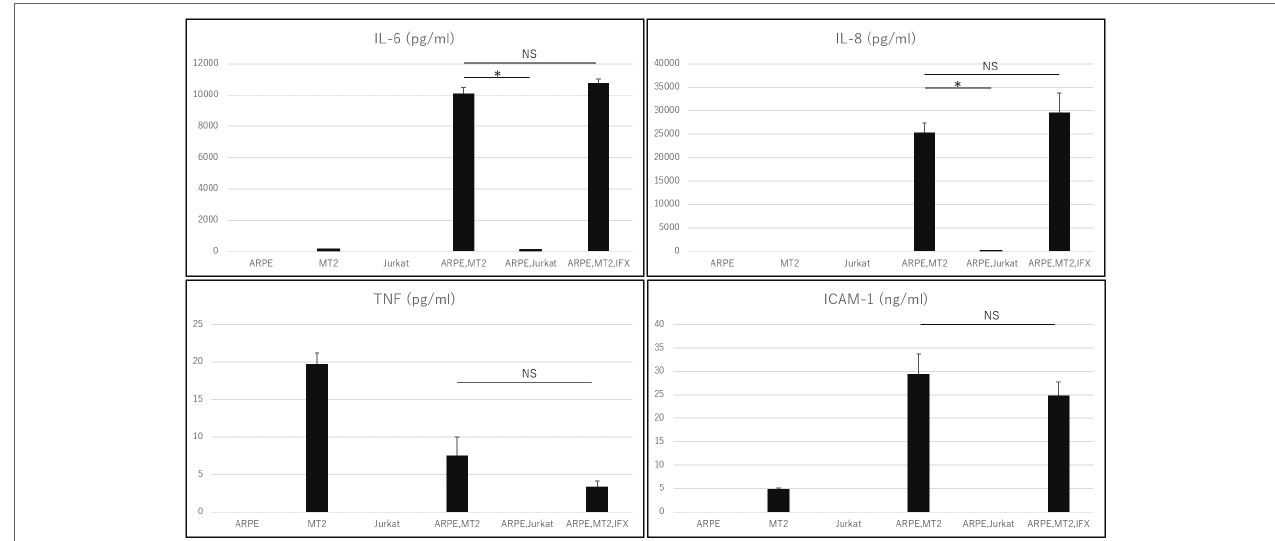
FIGURE 1 | Inflammatory cytokines and ICAM-1 secreted by ARPE, MT2, Jurkat, and ARPE-19 co-cultured with MT2 or Jurkat, and ARPE-19 co-cultured with MT2 with addition of IFX at 48 h. Although TNF tends to be inhibited by IFX, no significant difference is detected ( p = 0.14). Data were obtained from three independent biological replicates performed in triplicate. Error bars represent standard deviations (* p < 0.05; NS, not significant).